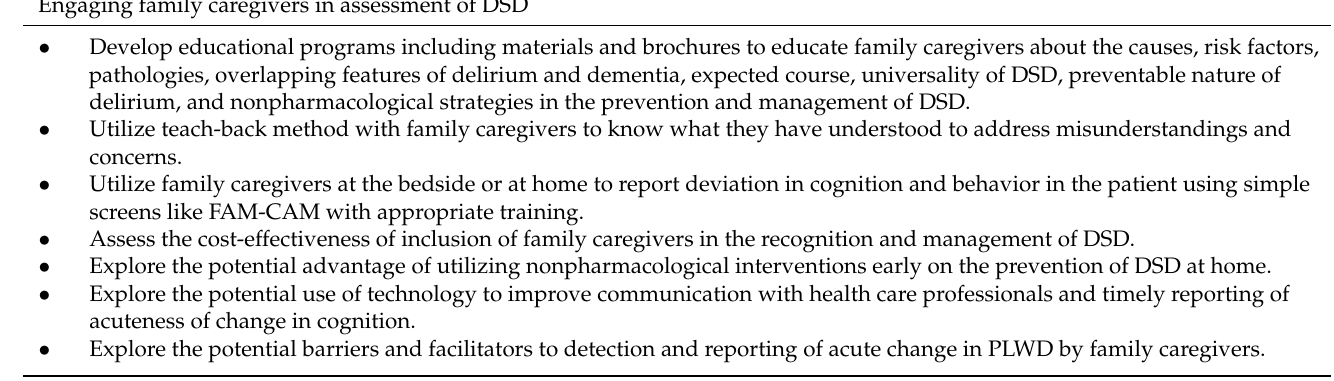
Table 4. Research, Policy, and Education Agenda for Detection of Delirium Superimposed on Dementia in Older